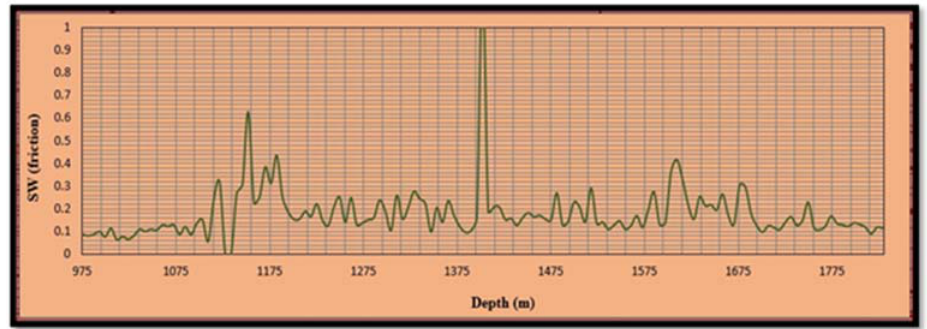
Figure 21. Water saturation along the depth.